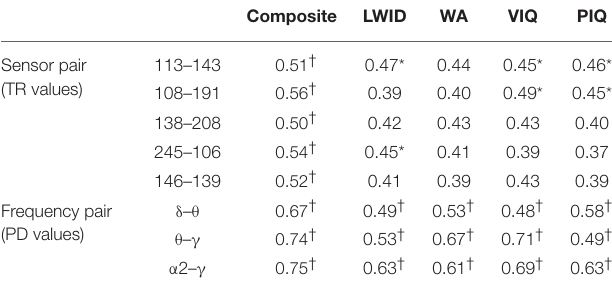
TABLE 2 | Significant partial correlations between reading achievement/IQ measures and TR or PD values at right temporo- parietal sensors (RD